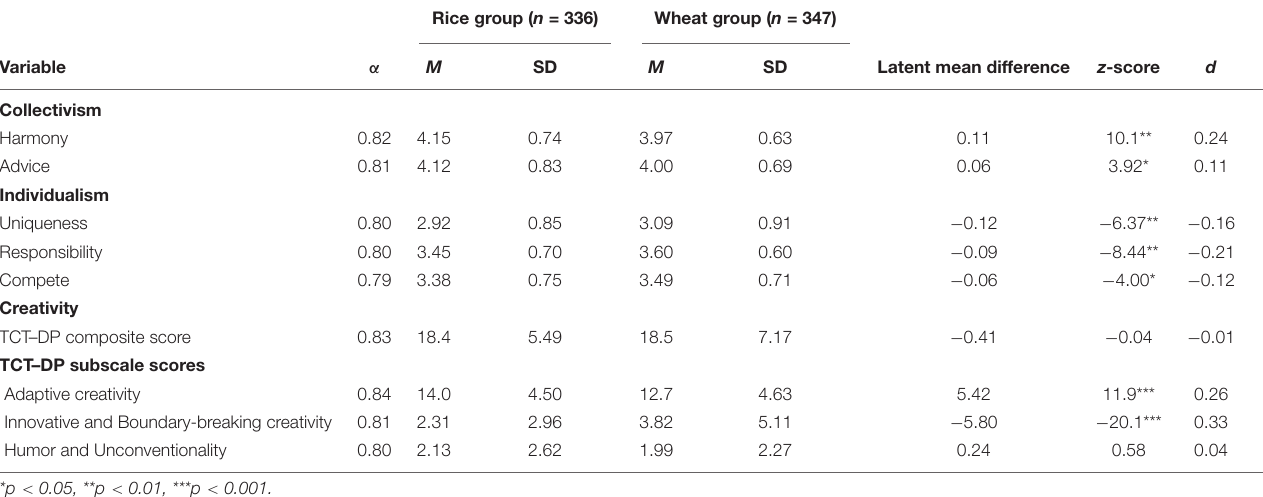
TABLE 5 | Descriptive statistics and results of latent mean comparisons.